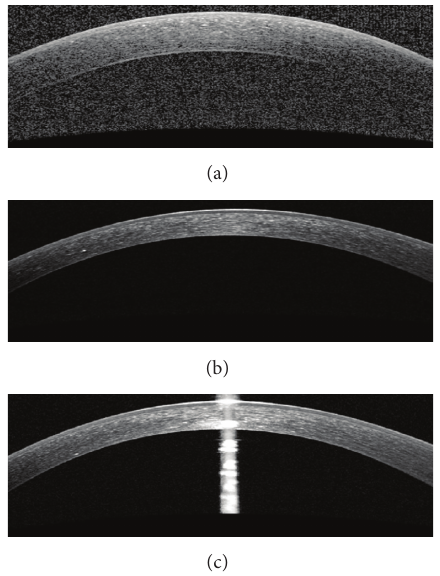
Figure 1: Examples of corneal images of varying signal to noise ratio (SNR) used in this study. (a) High SNR corneal image. (b) Low SNR corneal image. (c) Corneal image with central